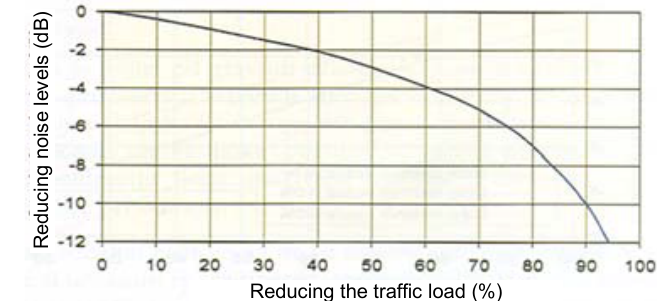
Figure 4 – Effect of reducing the traffic load on the noise level Рис . 4 – Влияние снижения дорожно - транспортного движения на уровень шума Slika 4 – Uticaj smanjenja saobra ć ajnog optere ć enja na nivo